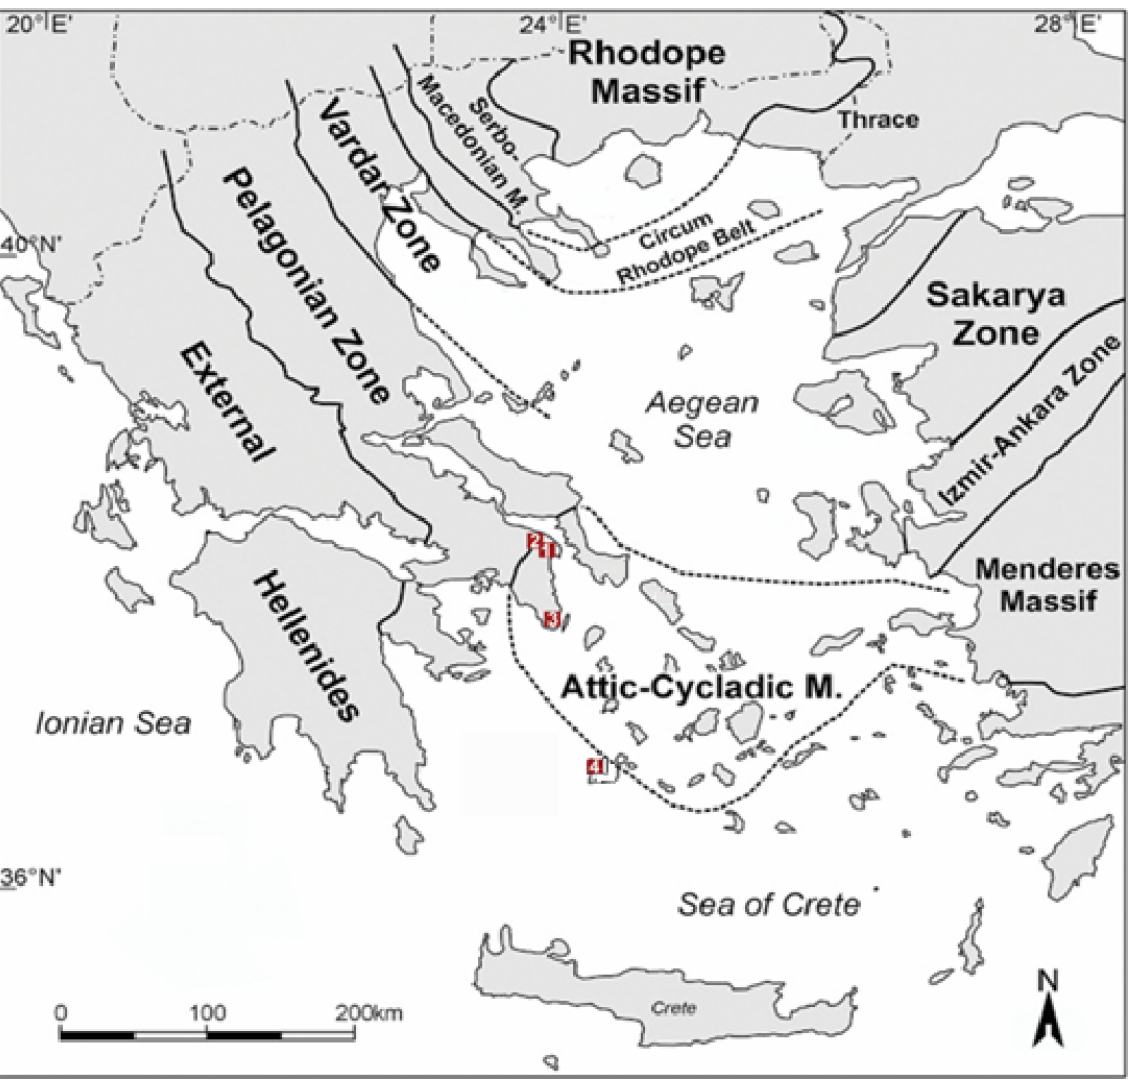
Figure 1. Geological sketch map of Hellenides presenting the main geotectonic units and the loca- tions of the studied Fe-Mn mineralizations in the Attic-Cycladic crystalline belt (Attic-Cycladic M.): 1: Grammatiko, Attica, 2: Varnavas, Attica, 3: Legrena, Attica, 4: Milos island. 1: Grammatiko, Attica, 2: Varnavas, Attica, 3: Legrena, Attica, 4: Milos